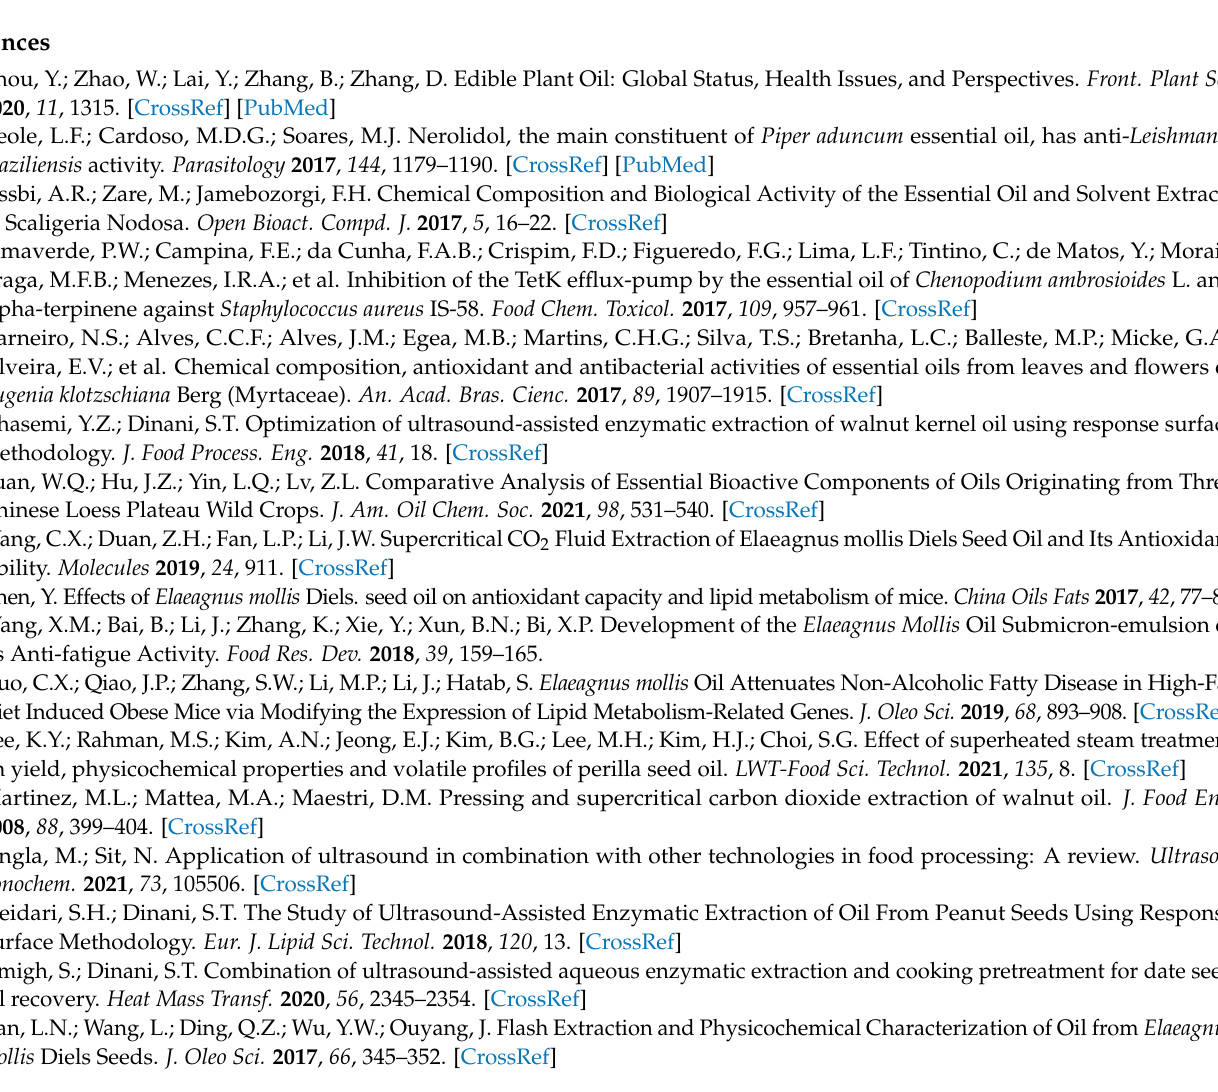
solution. Figure S2: Chroma-tograms of tocopherols and tocotrienols sample solution of UASEE oil. Figure S3: Quantitative ion chromatograms of squalene standard solution. Figure S4: Quantitative ion chromatograms of squalene sample solution of UASEE oil. Figure S5: Total ion chromatograms (TIC) of phytosterols standard solution. Figure S6: Quantitative ion chromatograms of phytosterols standard solution. Figure S7: Quantitative ion chromatograms of phytosterols sample solution of Figure S9: Quanti-tative ion chromatograms of phenolic compounds standard solution. Figure S10: Quantitative ion chromatograms of phenolic compounds sample solution of UASEE